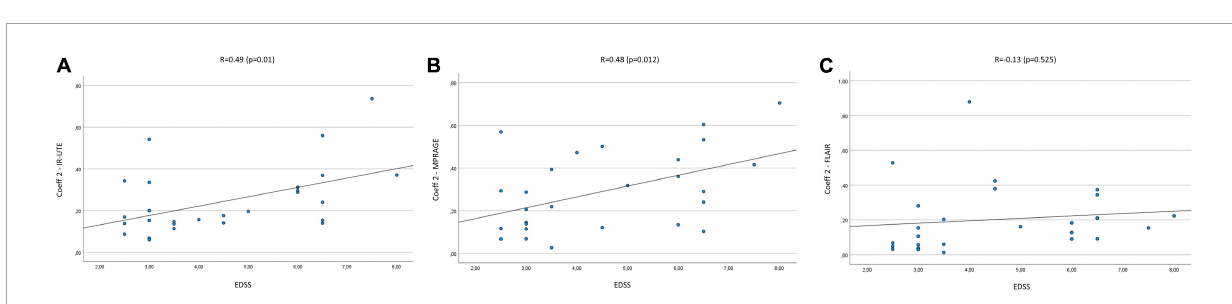
FIGURE3 Correlation of Coeff 2 in IR-UTE (A) , MPRAGE (B) , and FLAIR (C) images with the EDSS of MS patients.